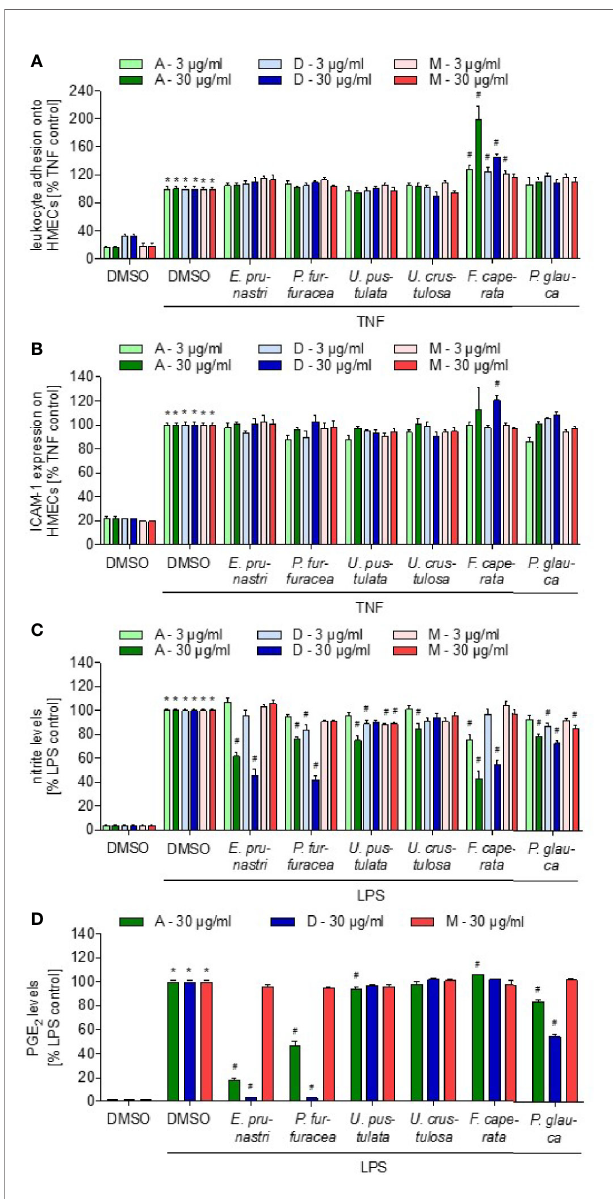
FIGURE 3 | Effects of lichen extracts on cellular functions. (A, B) HMEC-1 cells were grown to con fl uence, preincubated with lichen extracts (3 and 30 µg/ml) for 30 min, and activated with TNF (10 ng/ml) for 24 h. (A) For the leukocyte adhesion assay, untreated THP-1 cells were stained with CellTracker Green and were allowed to adhere onto the treated endothelial cells (ECs) for 5 min. Non-adherent THP-1 cells were removed by washing. The adhesion of leukocytes onto ECs was quanti fi ed by fl uorescence measurements. (B) For ICAM-1 expression analysis, cells were incubated with a fl uorescein isothiocyanate (FITC)-labeled ICAM-1 antibody for 45 min and the cell surface expression of ICAM-1 was quanti fi ed by fl uorescence measurements after washing. (A, B) Data are expressed as mean ± SEM. n=2, *p ≤ 0.05 versus dimethyl sulfoxide (DMSO) control; # p ≤ 0.05 TNF control. (C, D) For the nitric oxide (NO) (C) and prostaglandin E2 (PGE 2 ) (D) inhibition assay, RAW macrophages were preincubated with 3 or 30 µg/ml lichen extracts or DMSO (control) for 30 min followed by the addition of 100 ng/ml lipopolysaccharide (LPS) for 24 h. Data are expressed as mean ± SEM. n=3, *p ≤ 0.05 versus DMSO control; # p ≤ 0.05 LPS